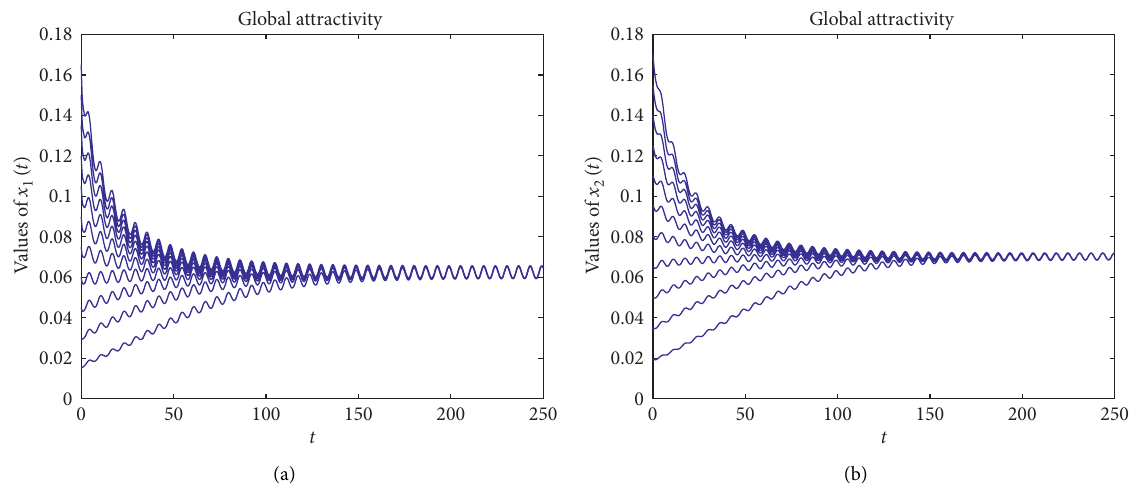
Figure 1: Global attractivity of system (39). Here, we take different initial